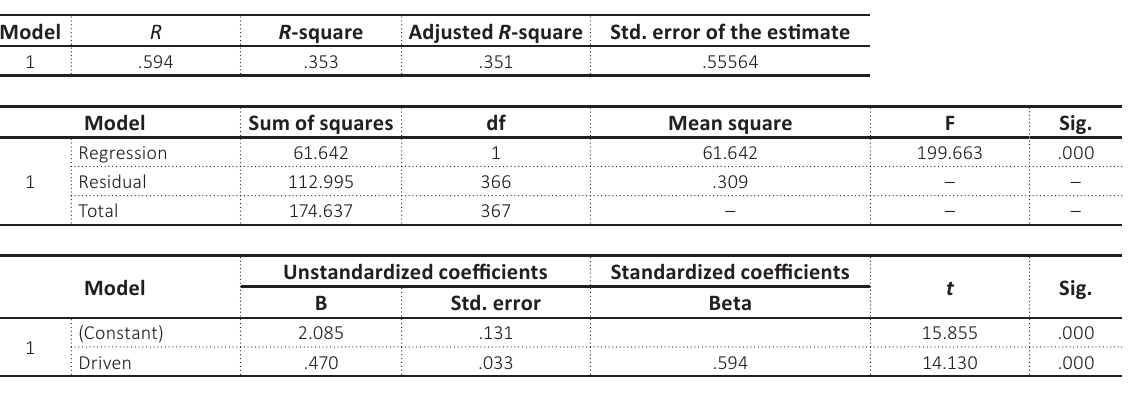
Table 6. Model summary, ANOVA and coefficients 3rd sub-hypothesis